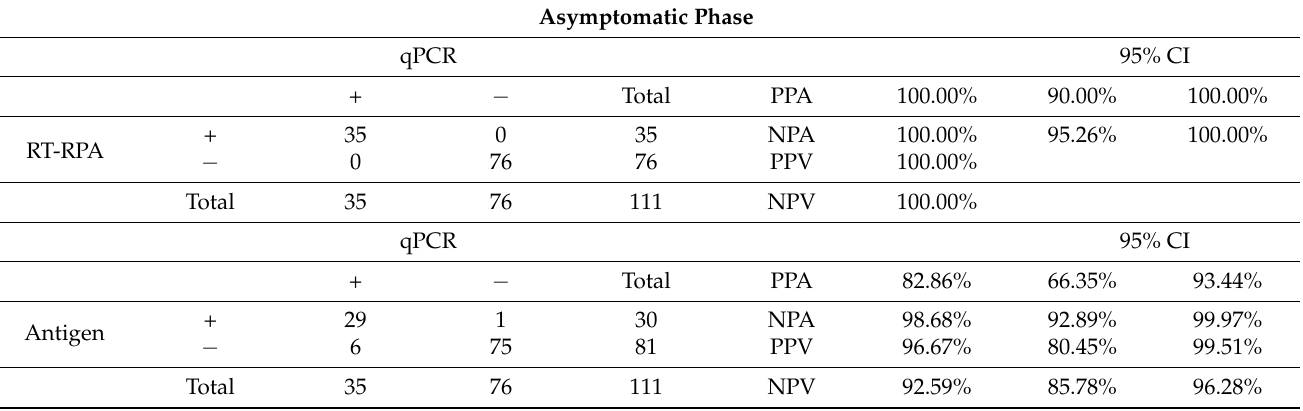
Figure 3. Clinical performance of the RT-RPA assay and the antigen test using nasal swab specimens collected from individuals with or without COVID-19. ( A ) Comparative evaluation of the RT-RPA assay (purple) and the antigen test (blue) using nasal swab specimens from asymptomatic cases. Comparative performance between the tests was plotted according to qPCR positive (Ct values between <20 to <40) and negative results. ( B ) Comparative evaluation of the RT-RPA assay (purple) and the antigen test (blue) using nasal swab specimens from symptomatic cases. Comparative performance between the tests was plotted according to qPCR positive (Ct values between <20 to <40) and negative results. Table 1. Comparative performance of the RT-RPA assay and the antigen test against qPCR in asymptomatic cases.